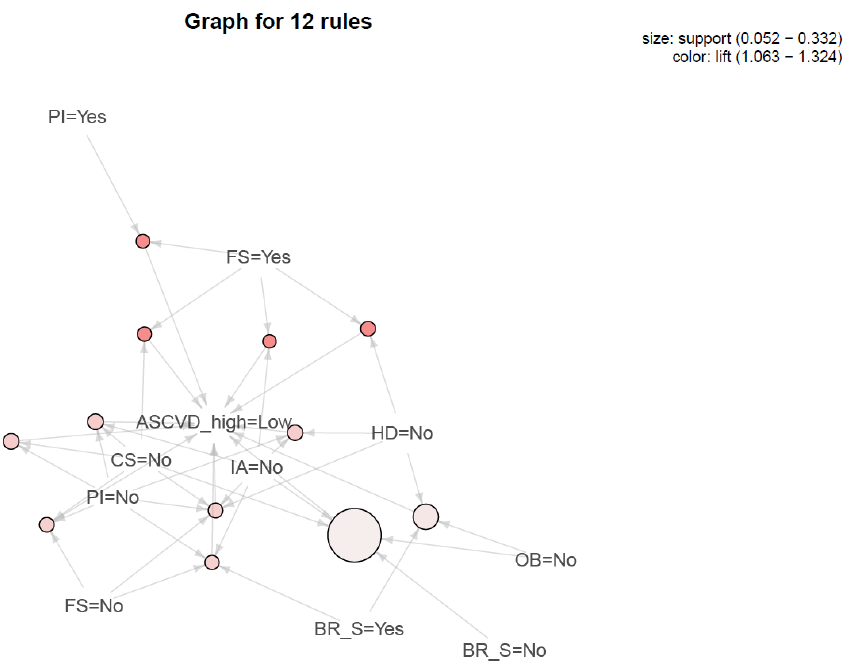
Figure 2. Association plot for female cancer survivors. CS, current smoking; HD, heavy drinking; PI, physical inactivity; OB, obesity; IS, inadequate sleep; BR_S, breakfast skipping; FS, frequent snacking; ASCVD, atherosclerotic cardiovascular disease.